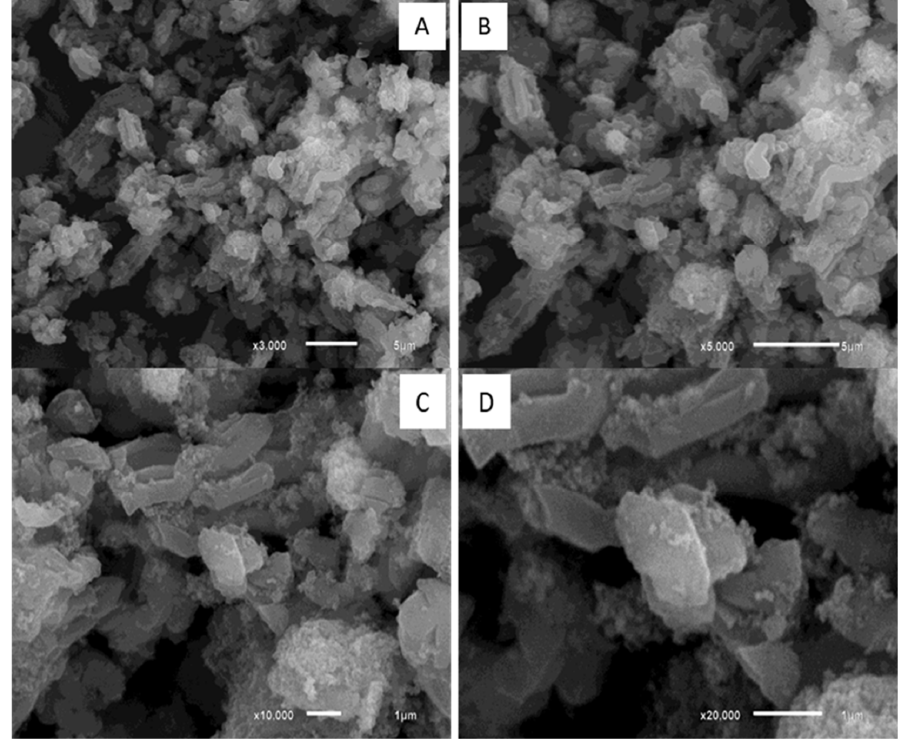
Figure 3. Scanning Electron Microscopy images of SBA-15/HAP_2 structures and their aggregates ( A – D ). The thermogravimetric profile analyses of the non-calcined materials are shown in Figure 4. The decomposition of the copolymer P-123 incorporated in the mesoporous ma- terial is observed, and possible species formed during the calcination step. The copolymer P-123 used as a structural leader in the materials synthesis has a boiling point of 250 °C. SBA-15, SBA-15/HAP_1, and SBA-15/HAP_2 samples exhibited small mass losses of 3.6%, 2.8%, and 9.4% at 30–115 °C, respectively. These mass losses are associated with the water elimination adsorbed on the mesoporous material surface, between the layers, and inside the mesopores.